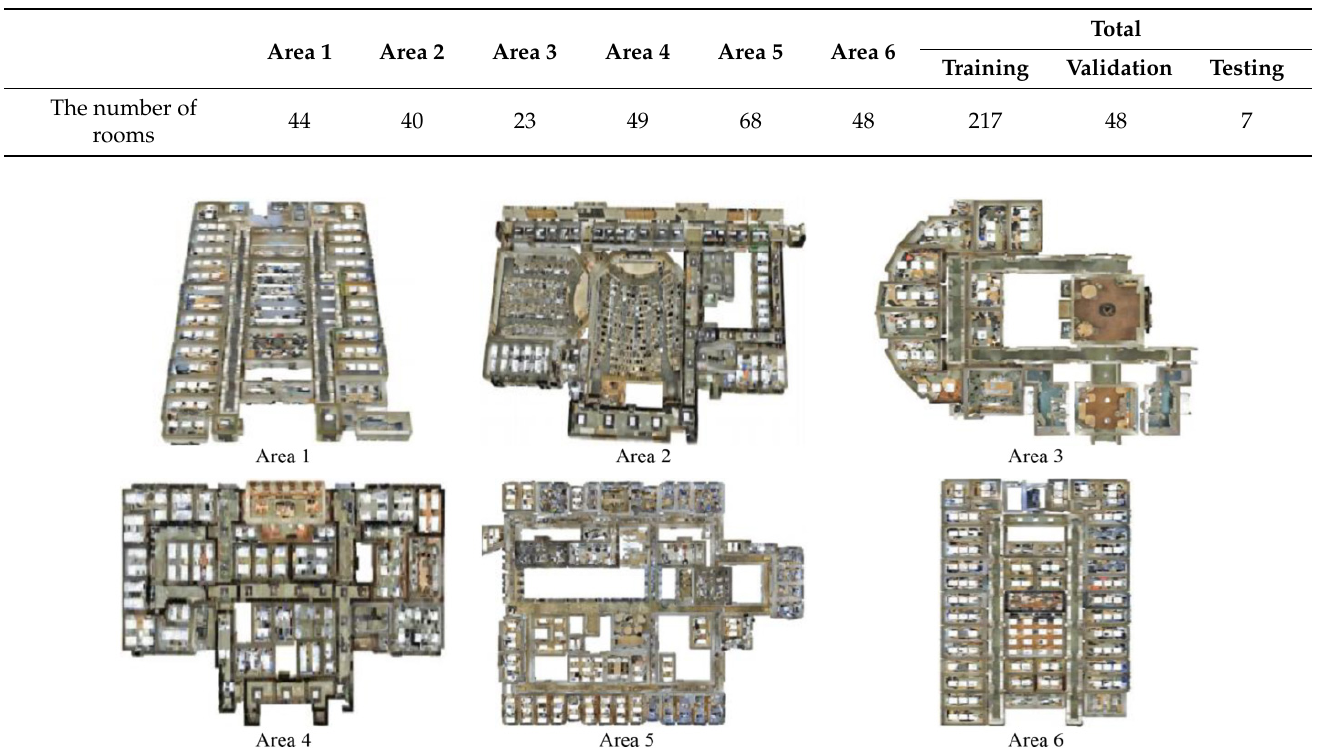
Table 2. Distribution of the number of rooms for the S3DIS dataset.